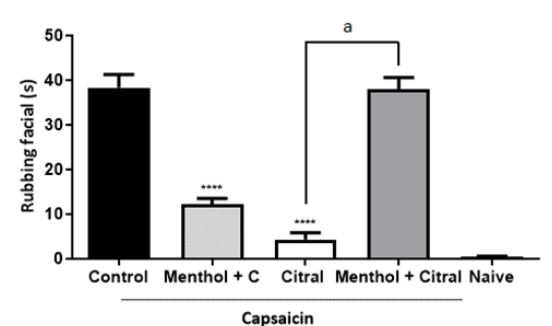
Figure 3: Involvement of the TRPM8 in the an- tinociceptive effect of citral (0.1 mg/Kg) in mice. Each column represents the mean ± S.E.M (n = 6/group). One-way ANOVA with post-hoc Tuk- ey’s test (****p<0.0001 vs control and a p<0.0001 vs Citral). C – vehicle control. Menthol (1.2 mM) was injected (intraperitoneal) 15, 30, 60, 120 and 240 minutes prior to citral or vehicle (control). Capsaicin (2.5 µg) was injected into the upper lip of animals 60 minutes after citral or vehicle (con- trol) administration. Citral and vehicle (control) were administered by gavage.